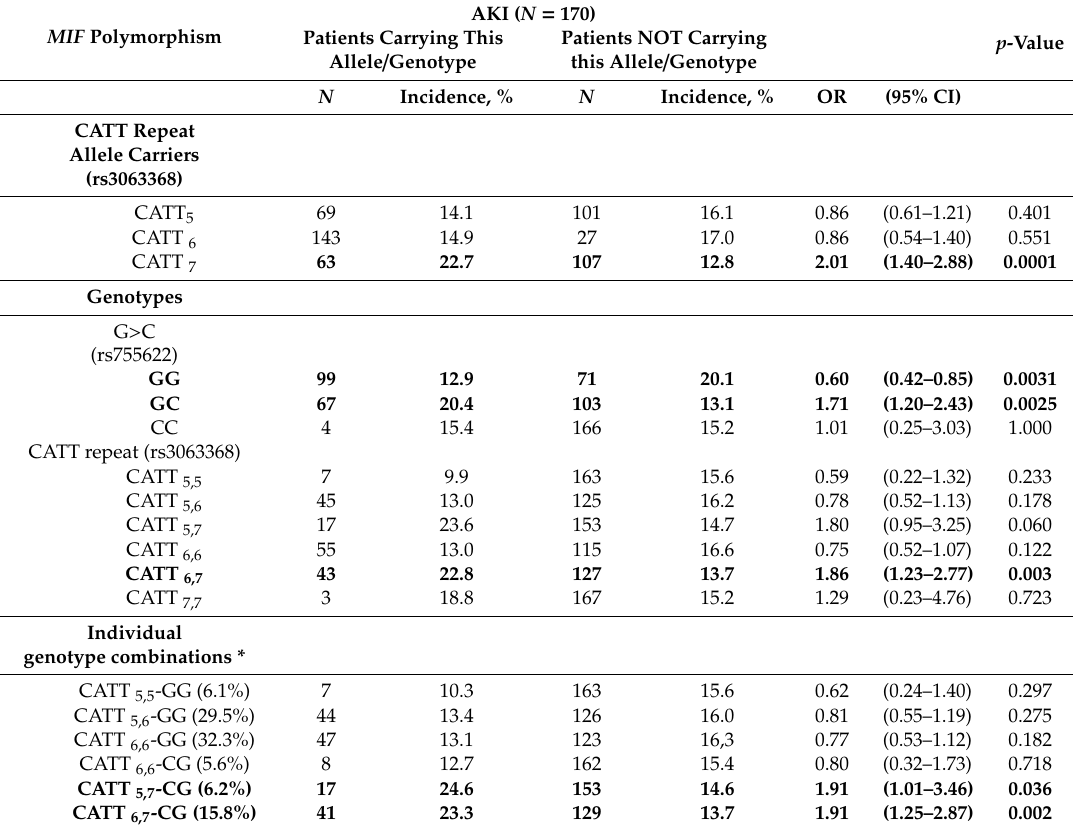
Table 4. Association of the MIF promoter polymorphisms with